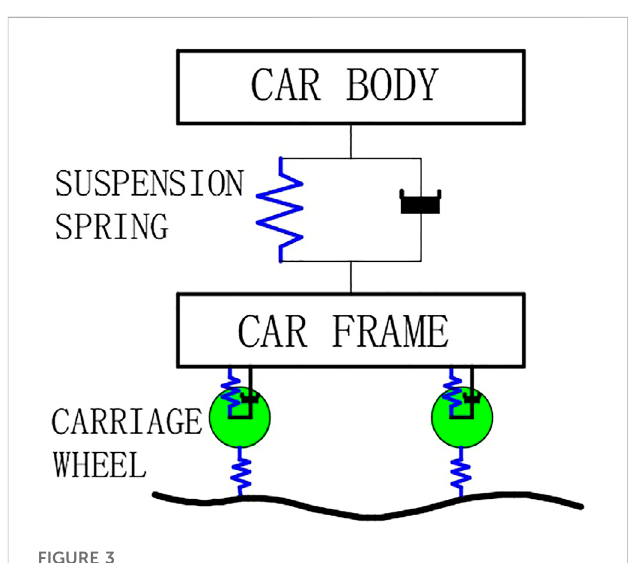
FIGURE 3 “ Half-car-track ” lumped parameter